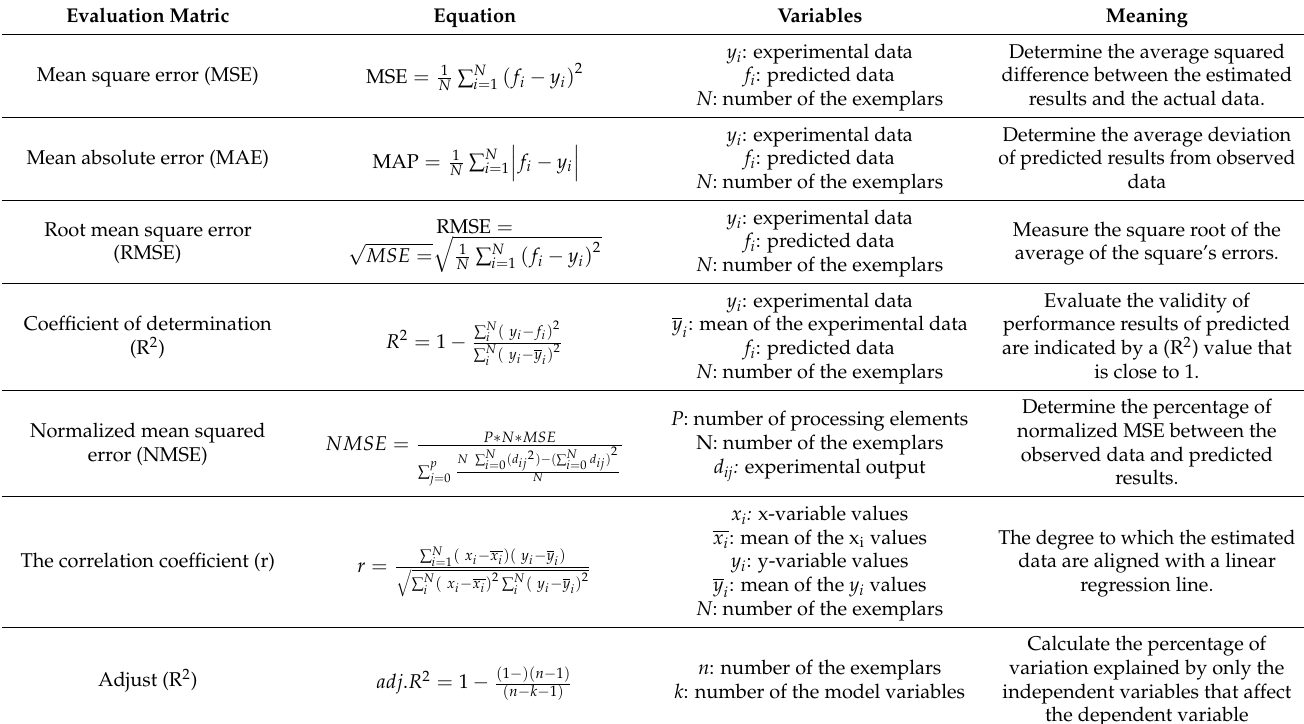
Table 3. The used standard performance evaluation metrics